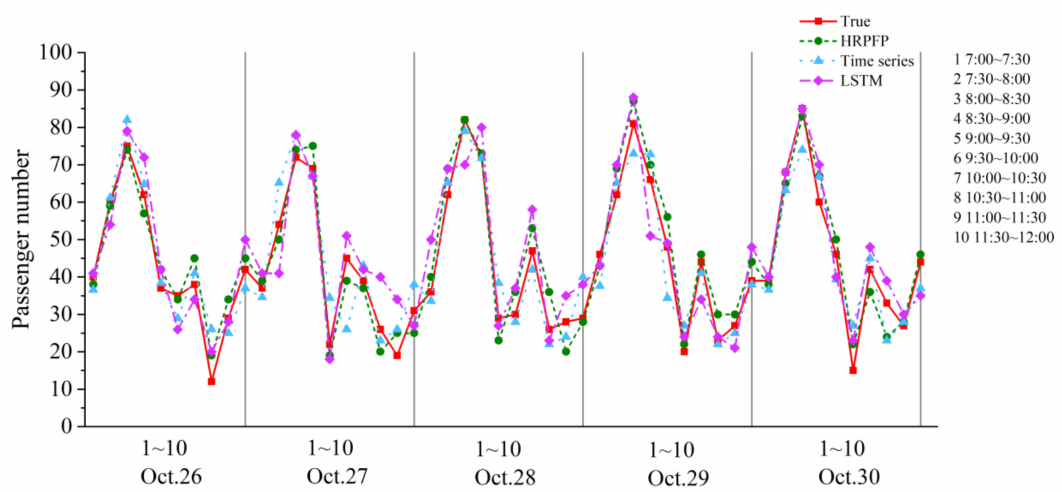
Figure 12. The comparison of three methods in passenger flow prediction using data from 7:00 to 12:00 for 7 th station in line